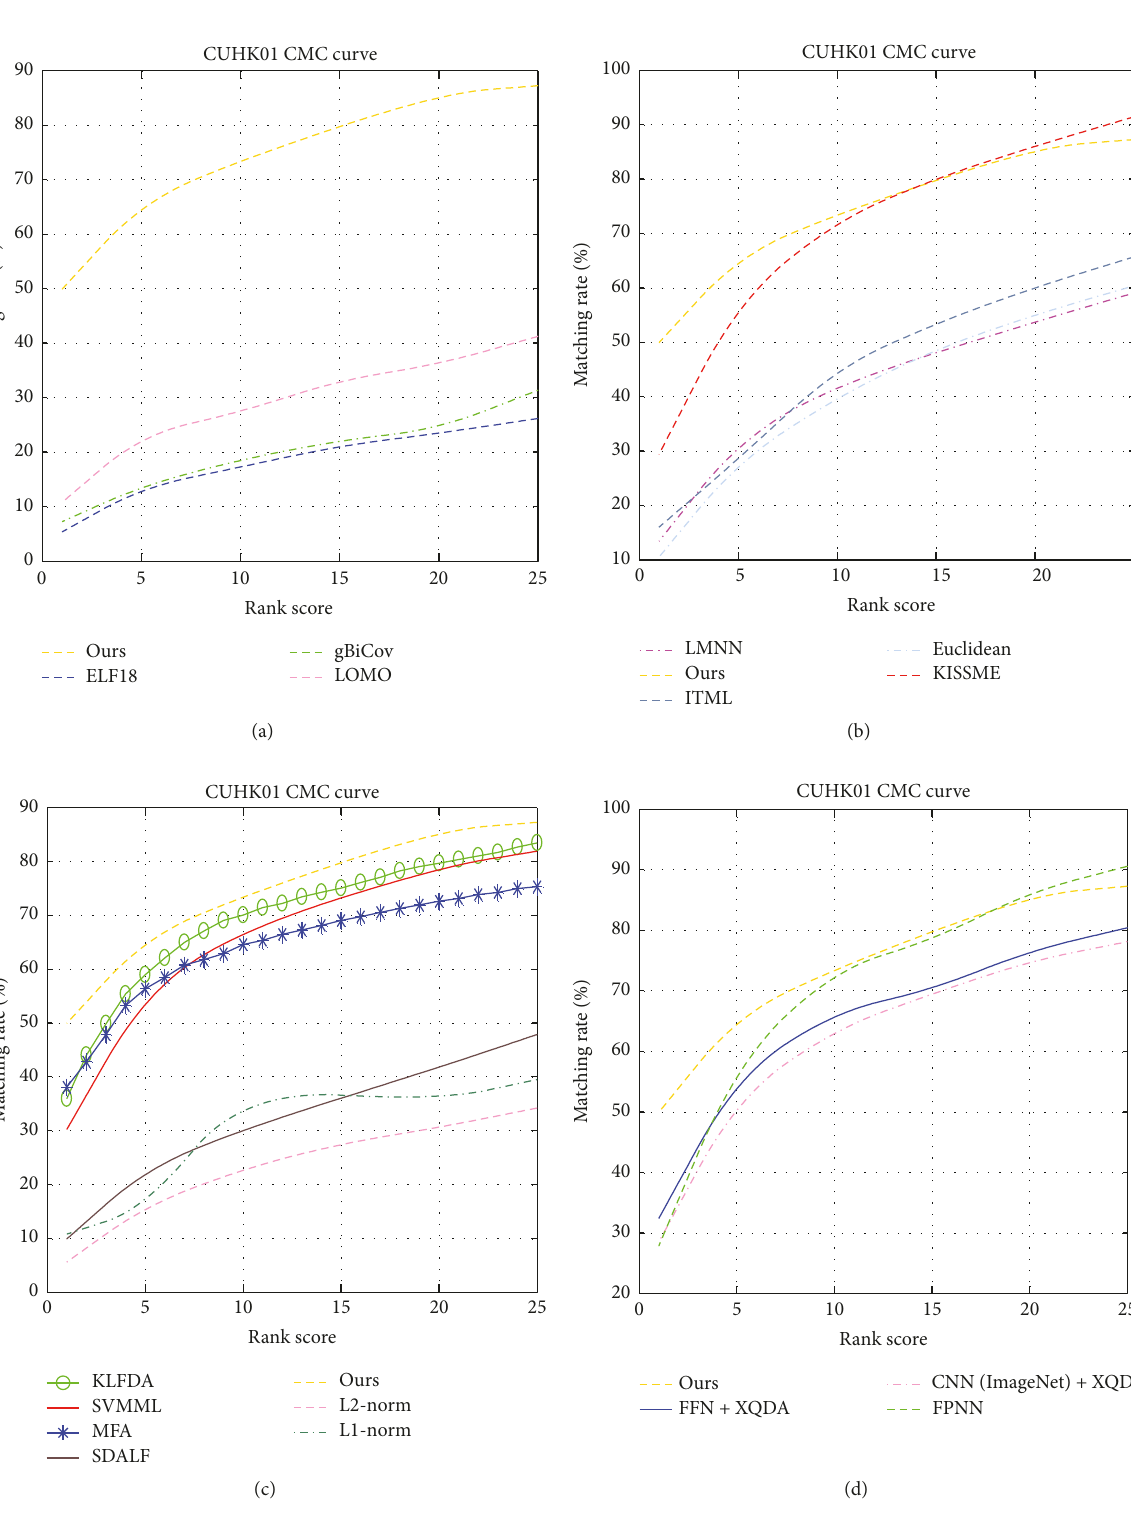
Figure 5: CMC curves on CUHK01 data set. (a) Performance comparison with feature representation algorithms; (b) performance comparison with metric learning algorithms; (c) performance comparison with other state-of-the-art algorithms; (d) performance comparison with other CNN-based